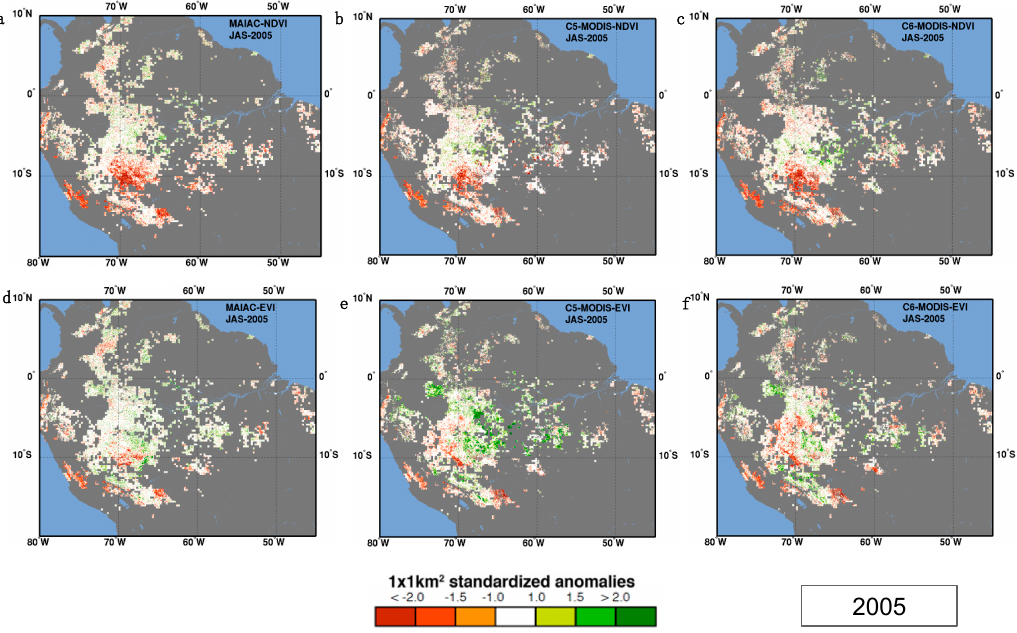
Figure 3. Spatial patterns of remotely sensed Amazonian dry season greenness standardized anomalies of the drought-affected vegetation, including forests, over Amazon in the 2005 drought year. The Amazonian dry season generally lasts from July to September (JAS). ( a ) Results from MAIAC NDVI data; ( b ) Results from Collection 5 MODIS NDVI data; ( c ) Results from Collection 6 MODIS NDVI data; ( d ) Results from MAIAC EVI data; ( e ) Results from Collection 5 MODIS EVI data; ( f ) Results from Collection 6 MODIS EVI data.